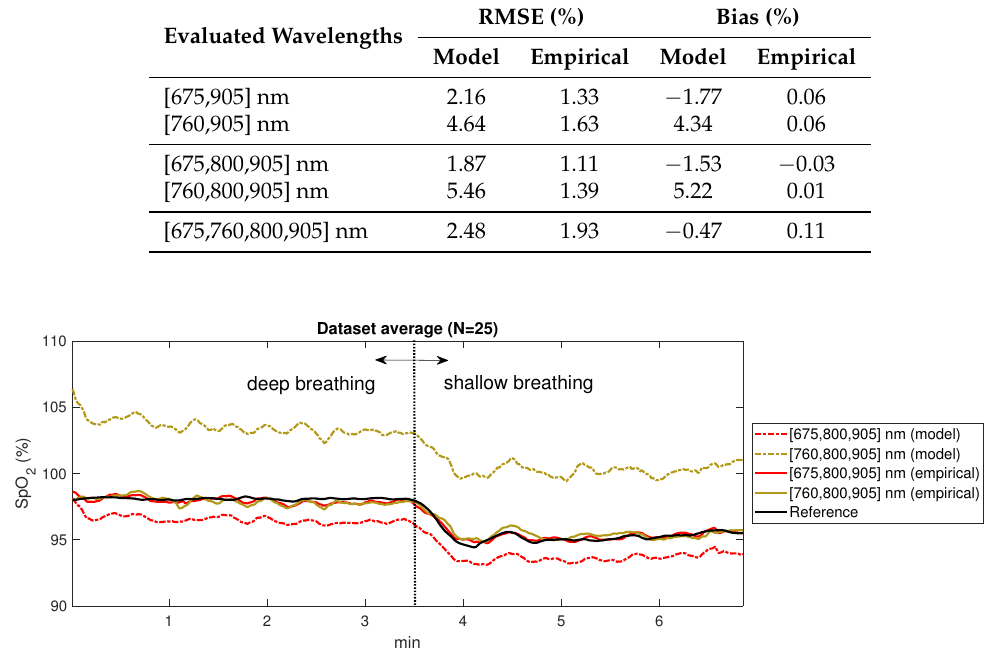
Figure 8. The average SpO 2 traces for the dataset ( n = 25) using the two evaluated three-wavelengths combinations, where the ∆ SpO 2 induced by the breathing protocol can be clearly observed.